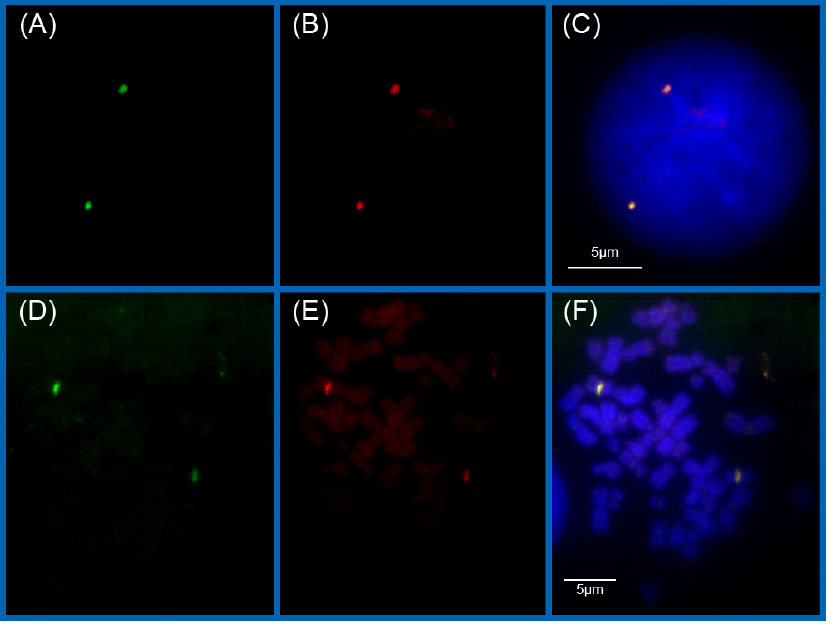
Figure 1. Examples of a lymphocyte cell nucleus ( A – C ) and a metaphase spread ( D – F ) after simultaneous labeling of the centromeric region of chromosome 9 with PNA COMBO-FISH probes. ( A , D ) green image plane: OregonGreen 488  ( λ = 496/524 nm). ex/em ( B , E ) red image plane: TexasRed  ( λ = 595/615 nm). ( C , F ) The merged images ex/em indicate a correct colocalization of the PNA signals. In addition, TOPRO-3-iodide was used for DNA